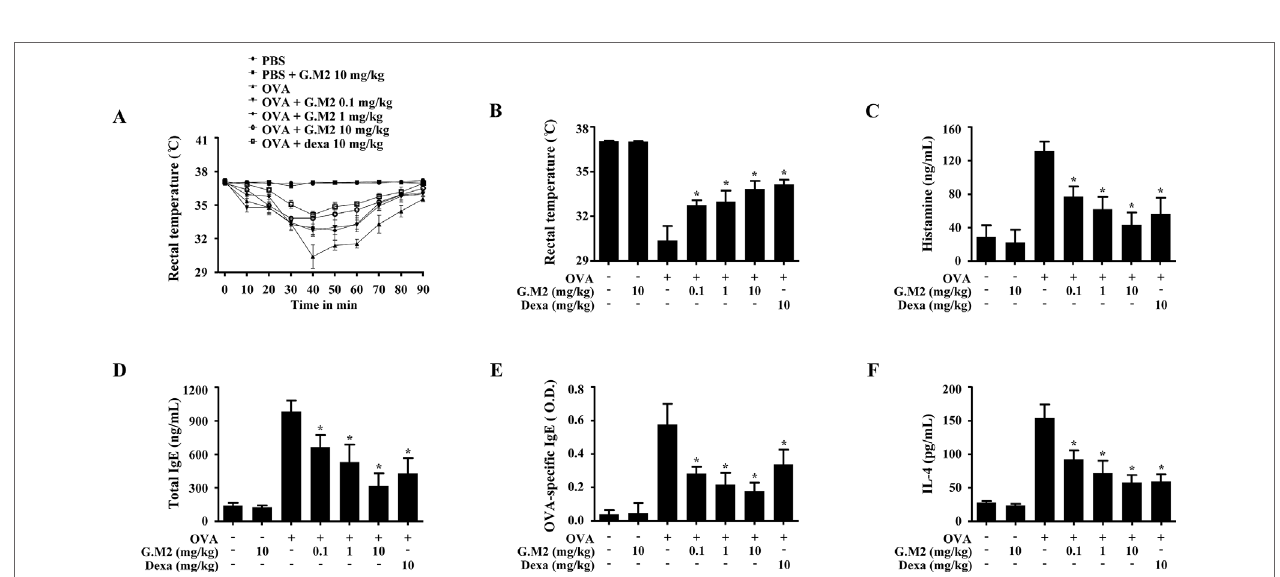
FIGURE 6 | Effects of G.M2 on ovalbumin (OVA)-induced active systemic anaphylaxis (ASA). Each mouse (total n = 35, n = 5/group) was intraperitoneally injected OVA mixture (100 µ g of OVA and 2 mg of alum adjuvant) or PBS on days 0 and 7. G.M2 (0.1–10 mg/kg) and Dexa (10 mg/kg) were orally administered on days 9, 11, and 13. On day 14, mice were challenged with an intraperitoneal injection of 200 µ g of OVA, and rectal temperature was monitored and then recorded every 10 min for 90 min. Mice were euthanized after 90 min, and blood samples were collected from the abdominal artery. (A) Rectal temperature was measured every 10 min for a total of 90 min. (B) Rectal temperature of mice at 40 min. (C–F) Serum histamine, total IgE, OVA-specific IgE, and IL-4 were detected by ELISA. Each dataset presented as a graph represents the means ± SEM ( n = 5/group) of two independent experiments. * p < 0.05, compared with the OVA-challenged group. Dexa,